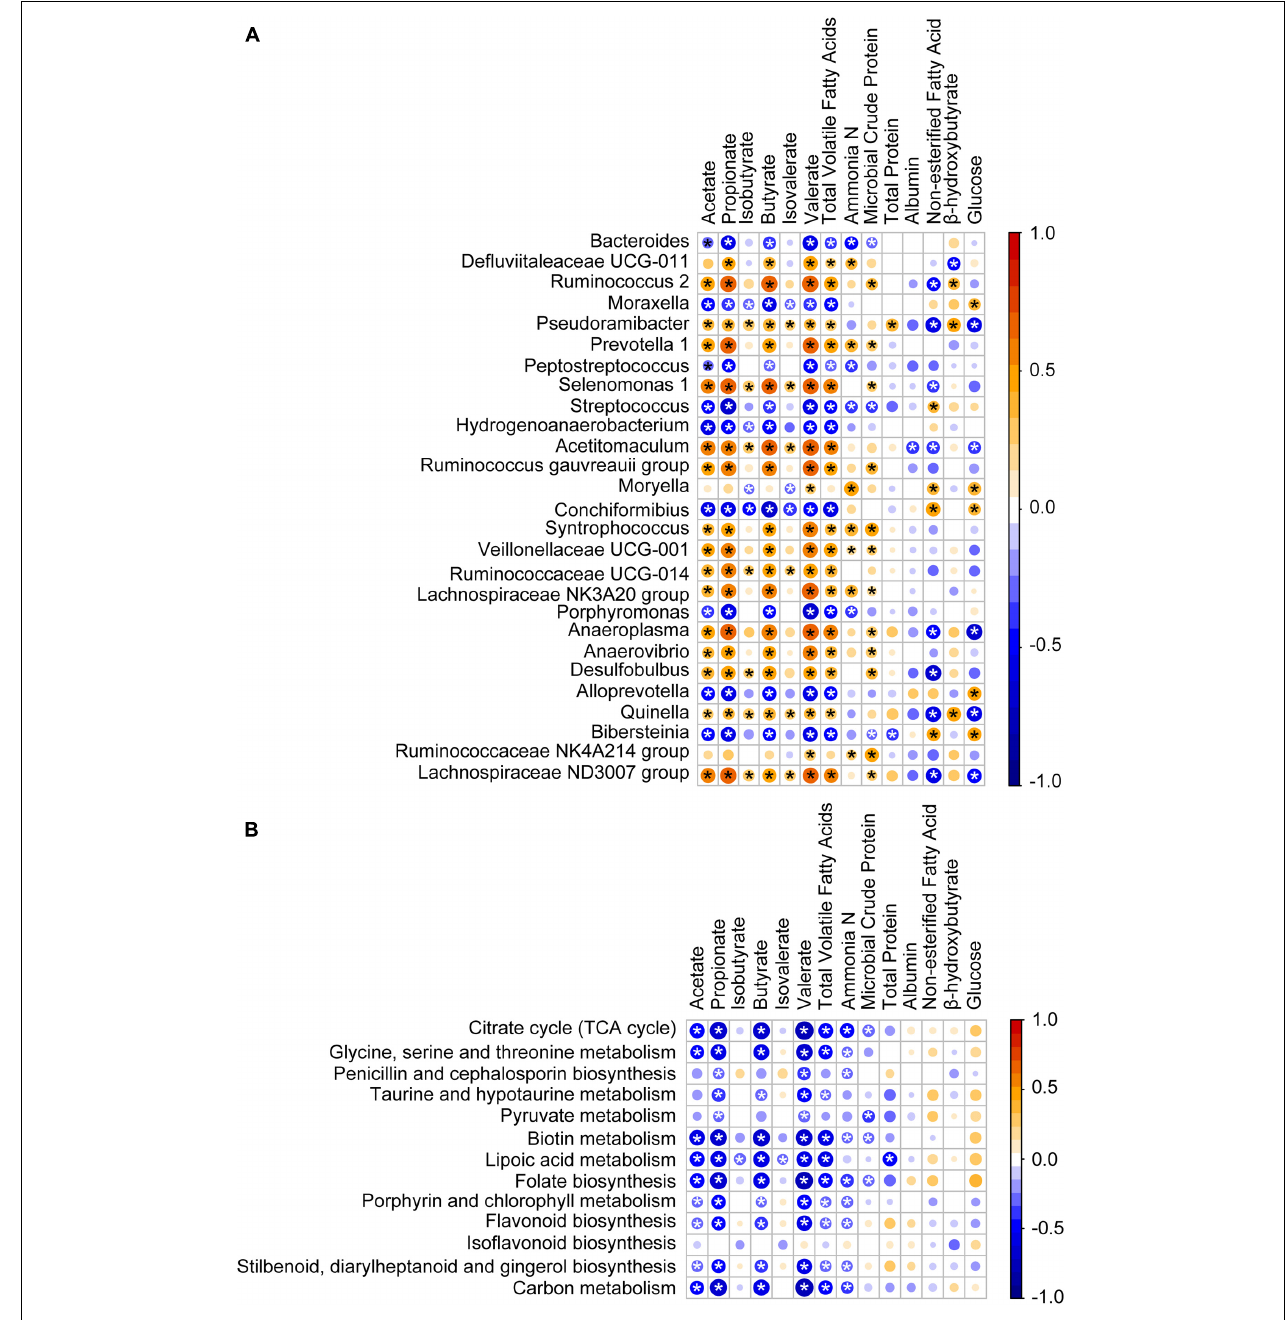
FIGURE 7 | Association of the age-associated genera and pathways with lamb ruminal fermentation and blood serum parameters. (A) Spearman correlation of ruminal fermentation, serum parameters, and age-associated genera identified by RandomForest. (B) Spearman correlation of ruminal fermentation, serum parameters, and age-associated pathway identified by RandomForest. Bubble size represents the absolute value of the correlation coefficient (r), and bubble color represents negative (blue) or positive (red) correlations, * P < 0.05.